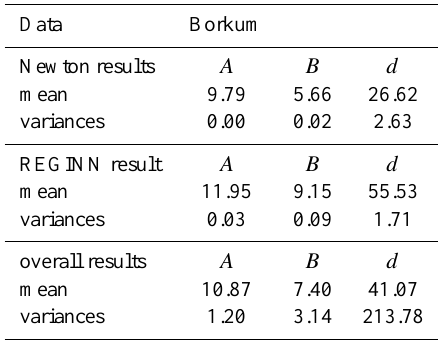
Table 2. Results of the inversion of the data set from Borkum. The Newton algorithm gives an unlikely estimate for the day of the an- nual minimum but the overall mean parameters fit the guess from Müller et al. (2013) within the desired